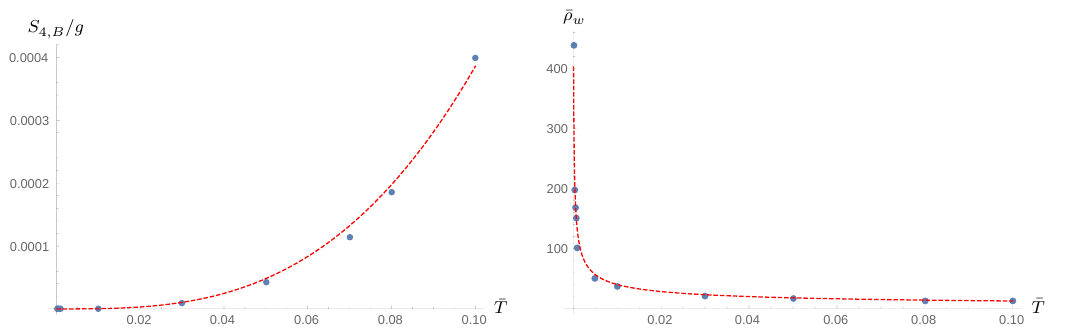
Figure 4 . The action S 4 ,B /g and dimensionless radius ¯ ρ w of the O(4) symmetric bubble as a function of ¯ T . Dots correspond to numerical results, the dotted lines to eq. (4.39).